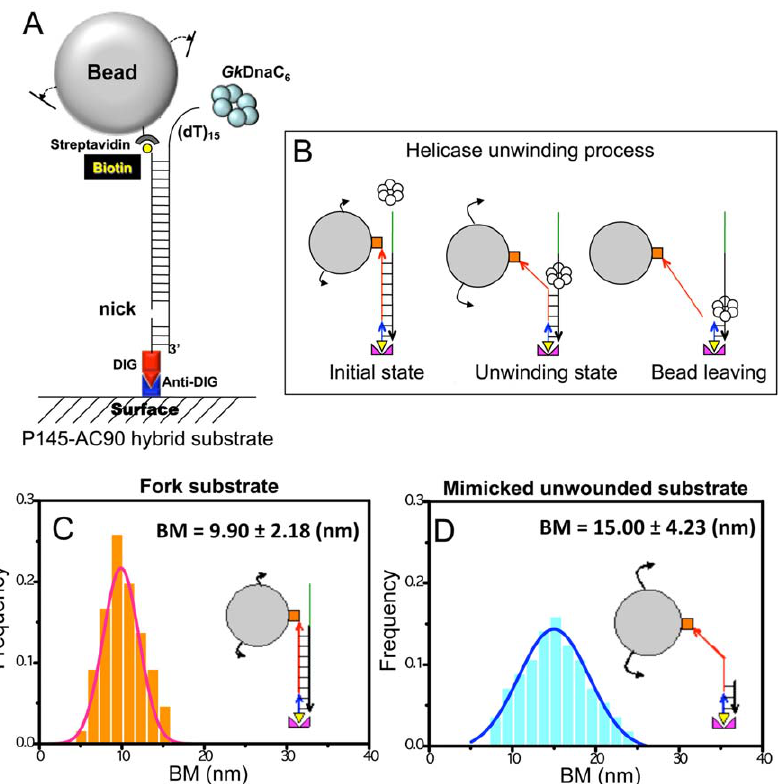
Figure 2. Single-molecule TPM to monitor Gk DnaC unwinding. A. Experimental geometry for monitor unwinding velocity. B. Gk DnaC- mediated unwinding leads to the conversion of duplex DNA into ssDNA, which is signaled by an increase in the BM of the bead, and eventually followed by bead-ssDNA disappearance. In the absence of helicase, a smaller, constant BM amplitude corresponding to the duplex substrate was observed. As Gk DnaC binds and initiates unwinding, BM starts to increases. Due to the design of the nicked substrate, the ssDNA-tethered bead disappears and signals the completion of unwinding of the 90 bp duplex. C. The initial BM distribution of the fork substrate with 108 bp duplex DNA and 37 nt ssDNA overhang allowing for Gk DnaC binding is 9.90 6 2.18 nm (mean 6 s.d., N=66). D. The BM for the mimicked unwound product before bead disappearance. The substrate contains a 37 bp duplex region with a nick and a 71 nt ssDNA. The BM increases to 15.00 6 4.23 nm (mean 6 s.d., N=57). It is feasible to monitor the helicase unwinding using the BM increase.